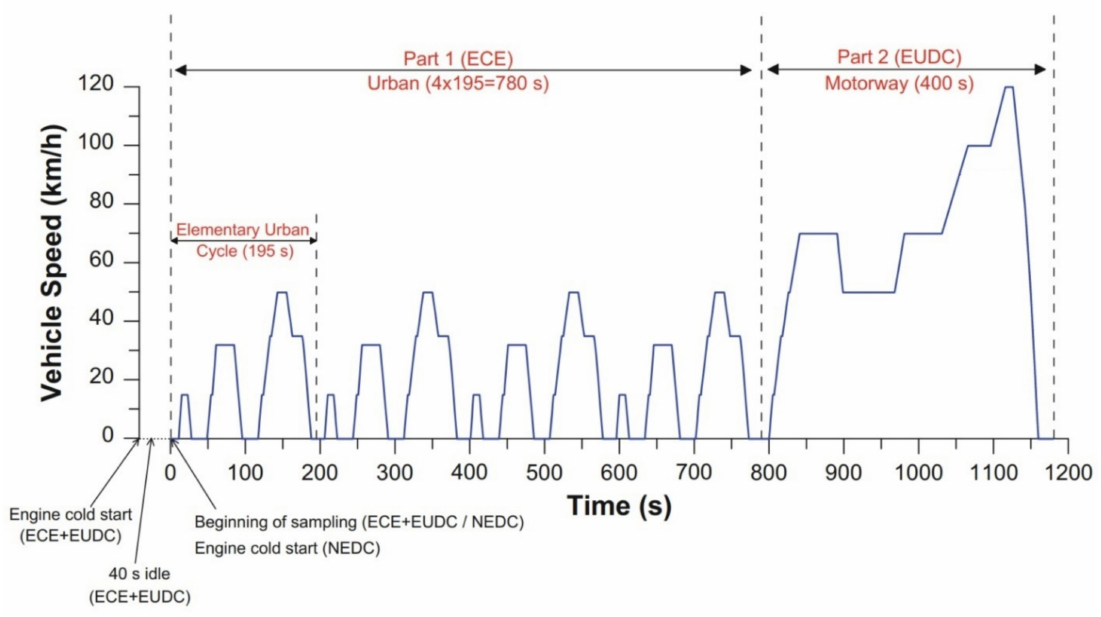
Figure 6. Speed-time cycle of ECE+EUDC/NEDC driving profile